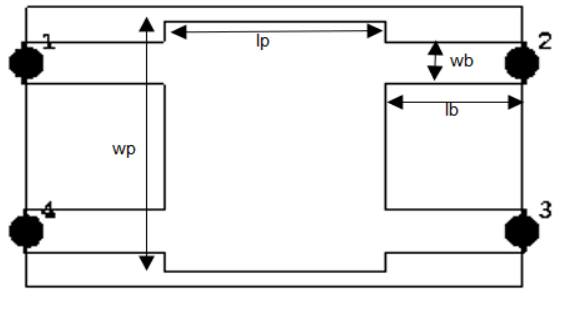
Fig.4. Two output ports phase of the conventional